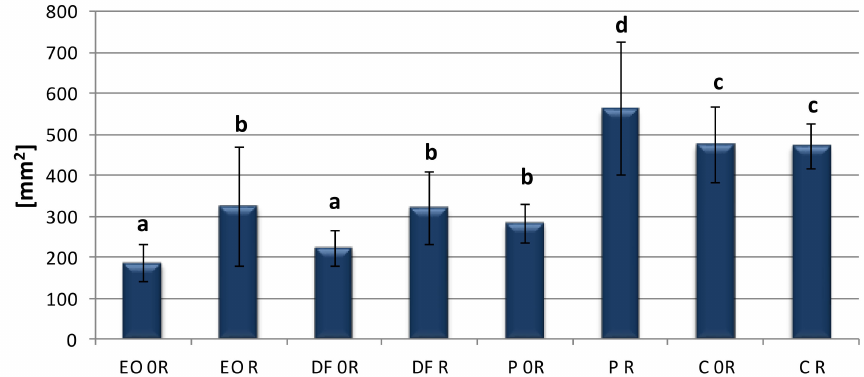
Figure 3. The e ff ect of petroleum-derived substances and bioremediation on the surface of the area of consumed places in leaves per plant caused by Sitona spp. (mm 2 ). Symbols as in Table 1. Means ( ± SE) marked with the same letters do not di ff er significantly according to the LSD test at p <